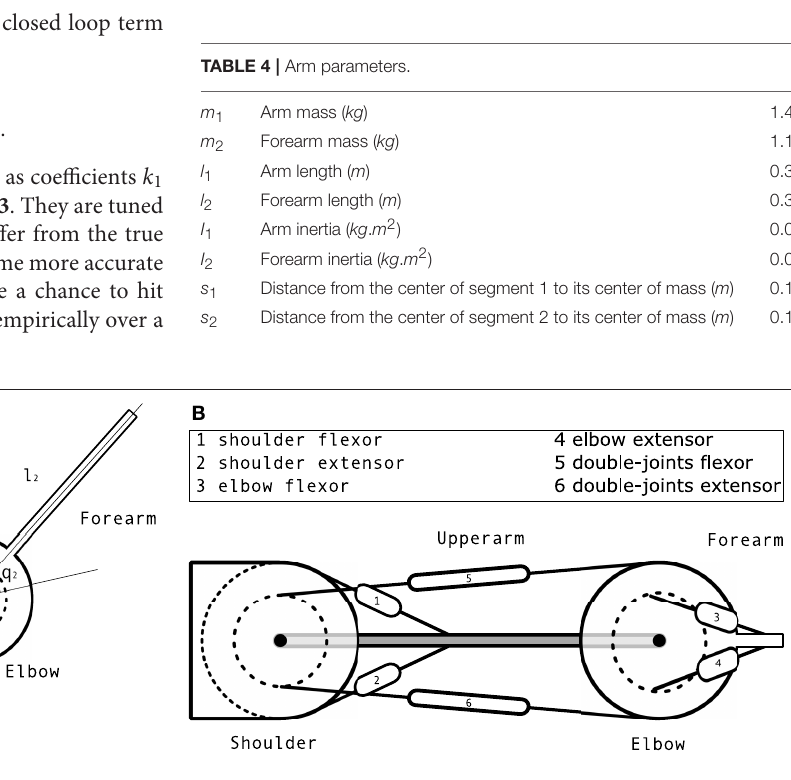
Frontiers in Human Neuroscience |